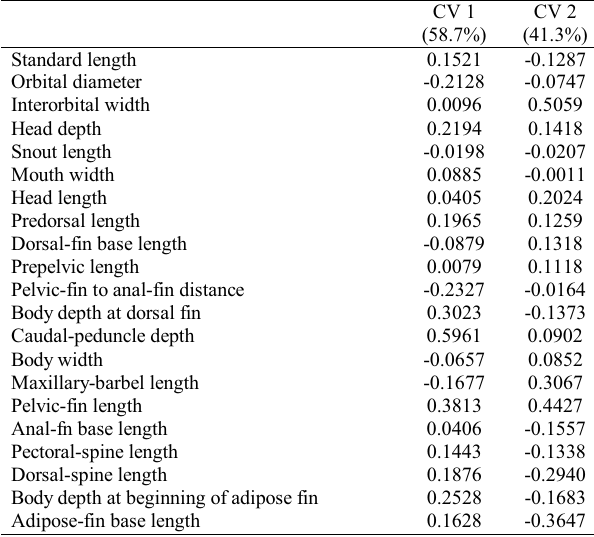
Table 2. First two size-free Canonical Variate axes (CV 1 and CV 2) from the analysis of combined samples of Microglanis carlae , M. garavelloi and M. parahybae (Total = 88 speci- mens).